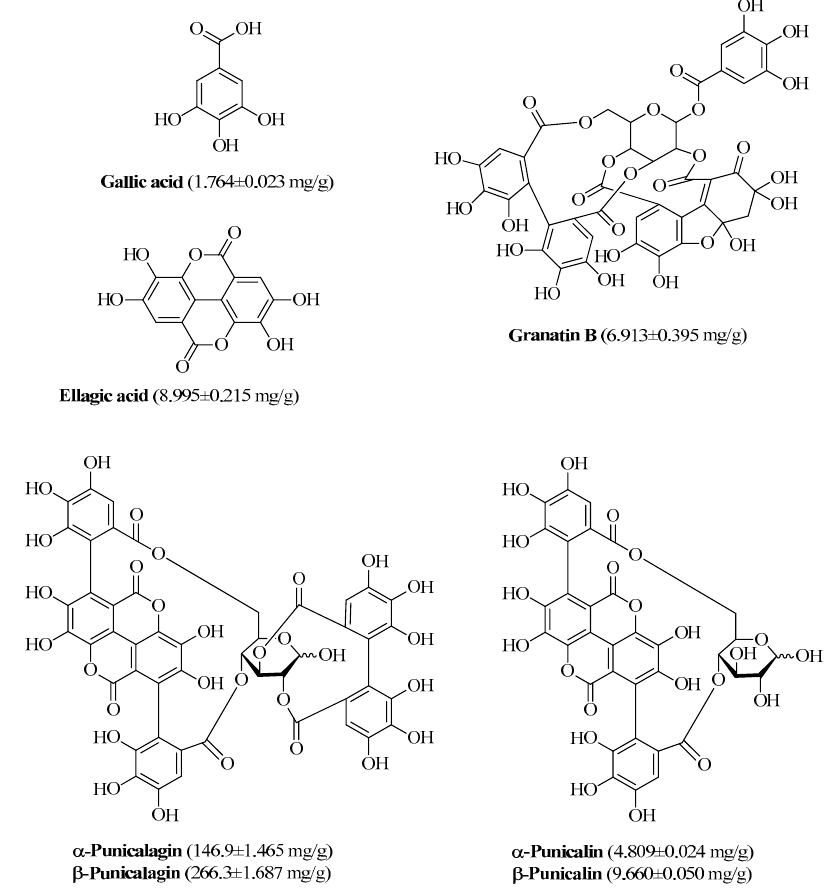
Figure 1. Phenolic compounds found in Pomegranate Peel Extracts (PPE) using High Performance Liquid Chromatography (HPLC) and Nuclear Magnetic Resonance (NMR) analyses. The HPLC analysis was carried out using a HP-1100 liquid chromatograph equipped with a Diode Array Detection (DAD) detector, a HP 1100 MSD API-electrospray (Agilent Technologies) detector and a Luna C18 column 250 × 4.60 mm. The NMR spectra were recorded using a 400 MHz nuclear magnetic resonance spectrometer Advance III.